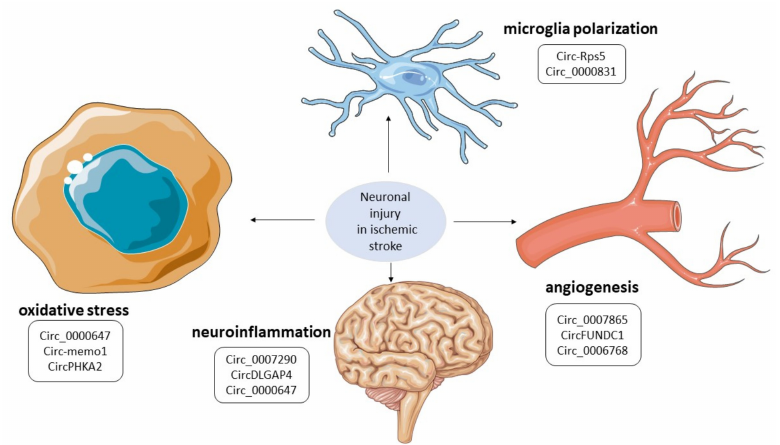
Figure 4. CircRNAs involved in key biological pathways of ischemic brain injury. CircRNAs are involved in several biological pathways that contribute to the pathophysiology of ischemic stroke by mediating pathophysiological mechanisms, including angiogenesis, neuroinflammation, microglial activation, and oxidative